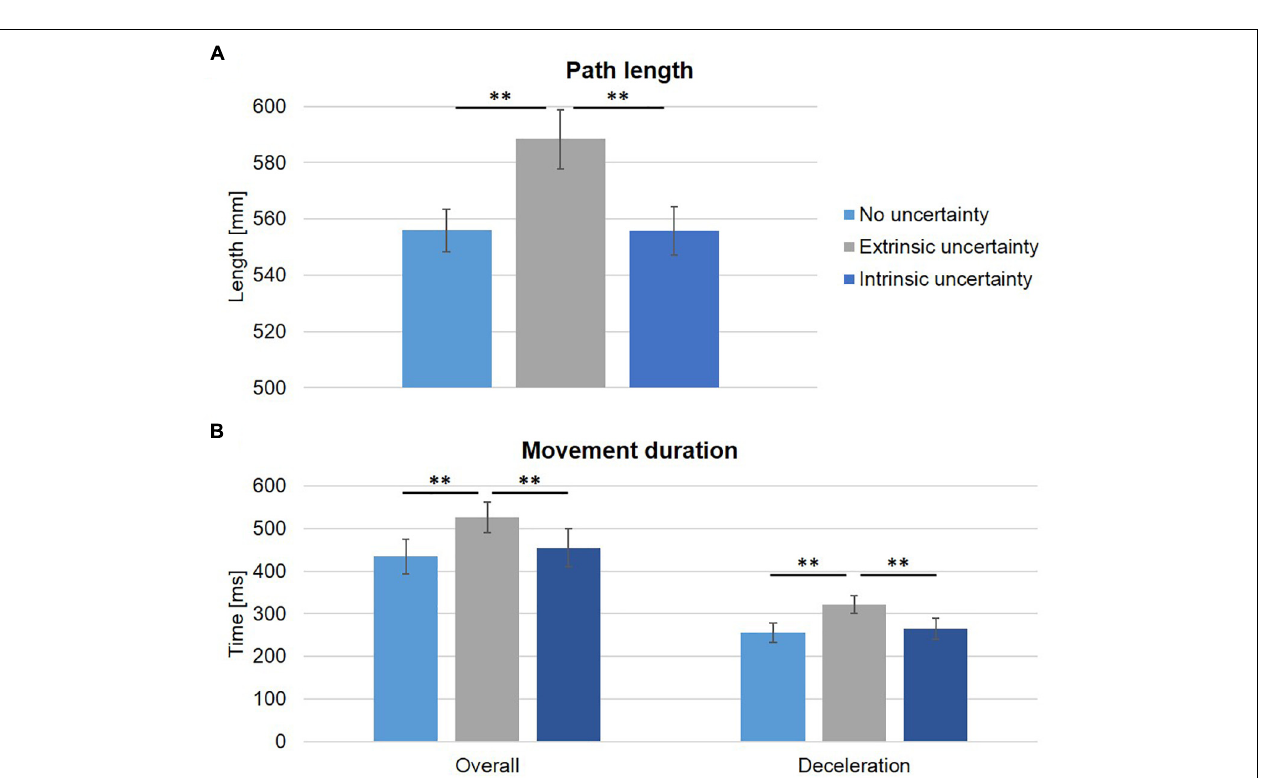
FIGURE 5 | Spatial and temporal movement characteristics. (A) The group averages ( ± SE) of path length (horizontal and vertical direction, in mm) are displayed for the three experimental conditions. Path length was significantly increased under extrinsic uncertainty as compared to the other two conditions. (B) Average overall movement duration and duration of deceleration are displayed. Again, the mean ± SE are plotted. Overall movement duration was significantly increased under extrinsic uncertainty, which was related to the significantly increased deceleration duration in this condition. Note that although the proportion of time spent after peak velocity was not statistically different between experimental conditions; ∗∗ p <